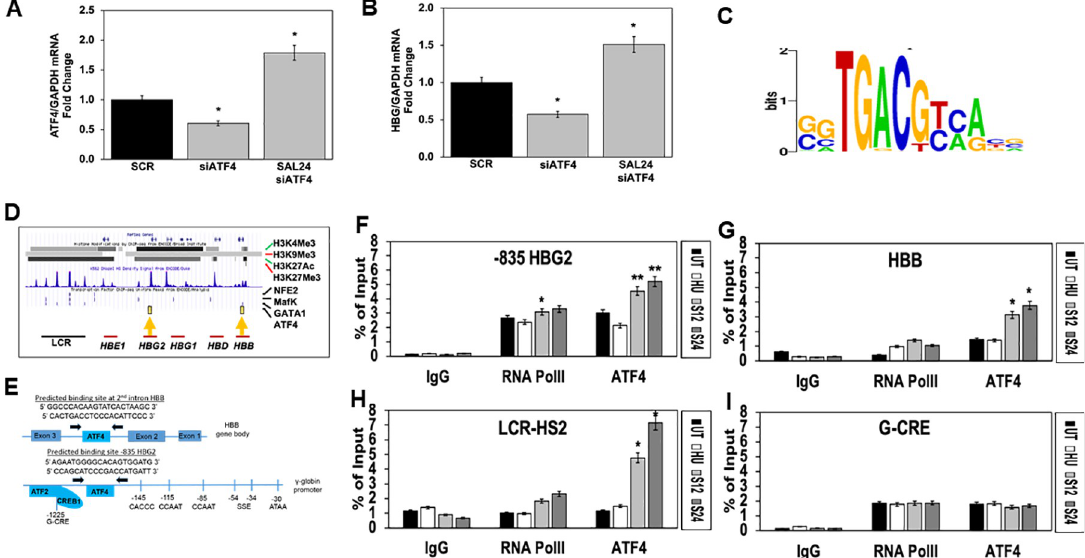
Fig 2. ATF4 binds to the HBG and HBB promoters to activate transcription. K562 cells were transfected with 200nM siATF4 or siRNA scrambled (SCR) control for 24 hours, followed by treatment with SAL (24 μ M) in triplicates for 48 hours. Total RNA was collected, and RT-qPCR analysis was performed to determine the levels of A) ATF4 and B) HBG mRNA expression levels after siATF4 transfection. C) ISMARA (Integrated System for Motif Activity Response Analysis) software was used to generate the ATF4 consensus binding sequence: 5’GTGA CGT [A/C] [A/G]’3. D) ChIPseq for K562 cells was downloaded from the ENCODE database which showed strong ATF4 binding in the region of the predicted motif -835bp HBG2 promoter and weaker binding in the second intron of the HBB gene (yellow arrows). E) Schematic of ChIP assay primer sequences used for qPCR analysis. F-I) K562 cells were treated with HU (75 μ M; white bar), SAL 12 μ M (light grey) and SAL 24 μ M (dark grey) for 48 hours and used for ChIP assay for IgG (non-specific binding control), RNA polymerase II (PolII) (transcription rate control), and ATF4 binding at the F) -835 HBG2 , G) HBB gene, H) LCR-HS2 and I) G-CRE (n = 3 per group). Data are shown as mean ± SEM and � p < 0.05; �� p < 0.01; ��� p < 0.001 was considered statistically